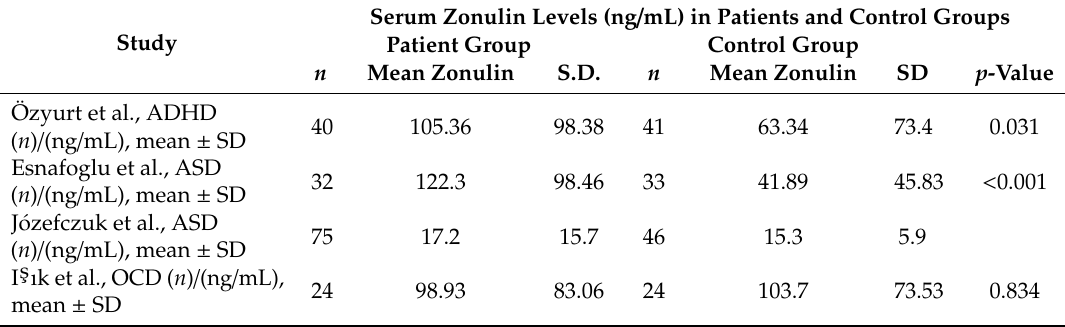
Table 5. Serum zonulin levels (ng / mL) in patients and control groups. Serum Zonulin Levels (ng / mL) in Patients and Control Groups Study Patient